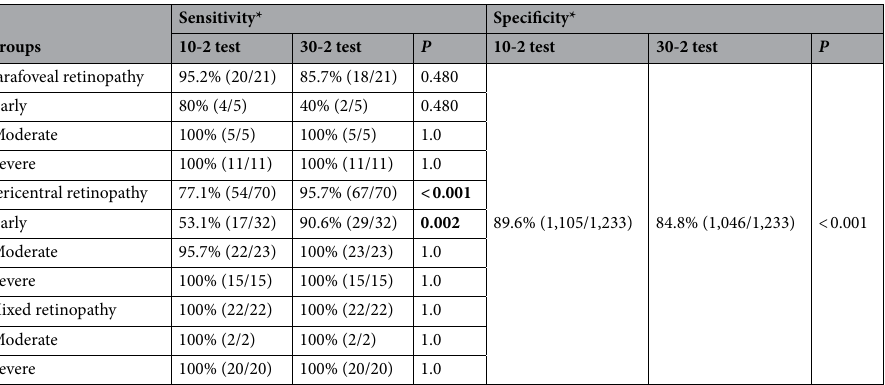
Table 4. Diagnostic performance of the Humphrey 10-2 and 30-2 visual field (VF) examinations for hydroxychloroquine retinopathy in subgroups according to retinopathy patterns and severities. Included were those that received both 10-2 and 30-2 tests (113 eyes with retinopathy and 1,233 healthy eyes). *Sensitivity = no. of diseased eyes showing VF abnormality on the strategy (correctly classified) / no. of all the eyes with retinopathy examined using the same strategy; specificity = no. of normal eyes with normal VF results on the strategy/ no. of all healthy eyes that received the same strategy. Significant values are in